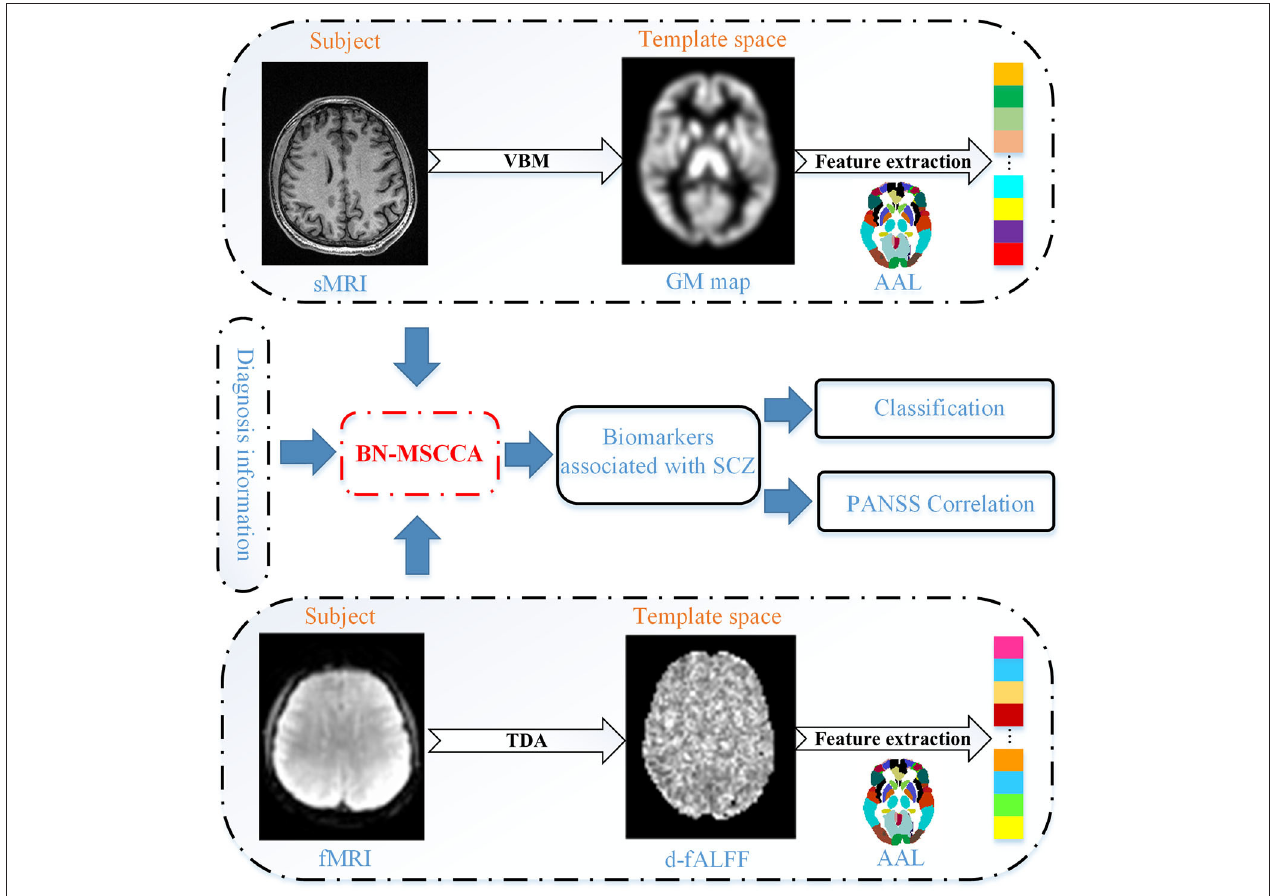
FIGURE 1 | The flowchart of our proposed